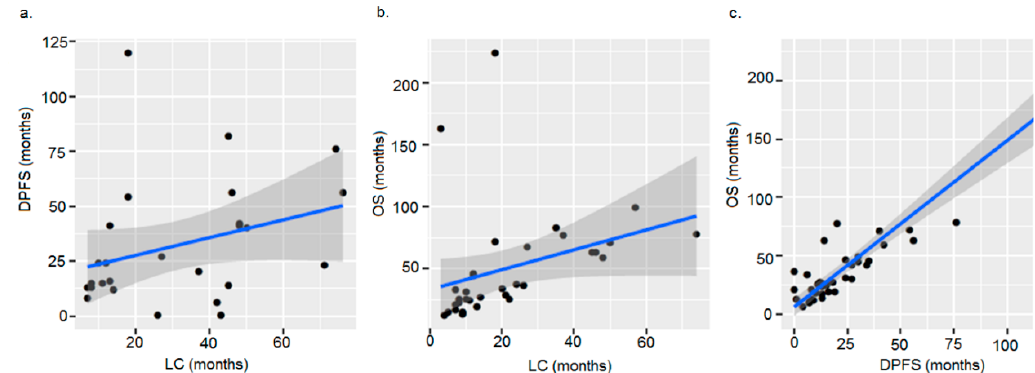
Figure 3. Correlation between local relapse and distant relapse ( a ), local relapse and overall survival ( b ) as well as distant relapse and overall survival ( c ) over time in months. Abbreviations: LC = local control, DPFS = distant progression-free survival, OS = overall survival.